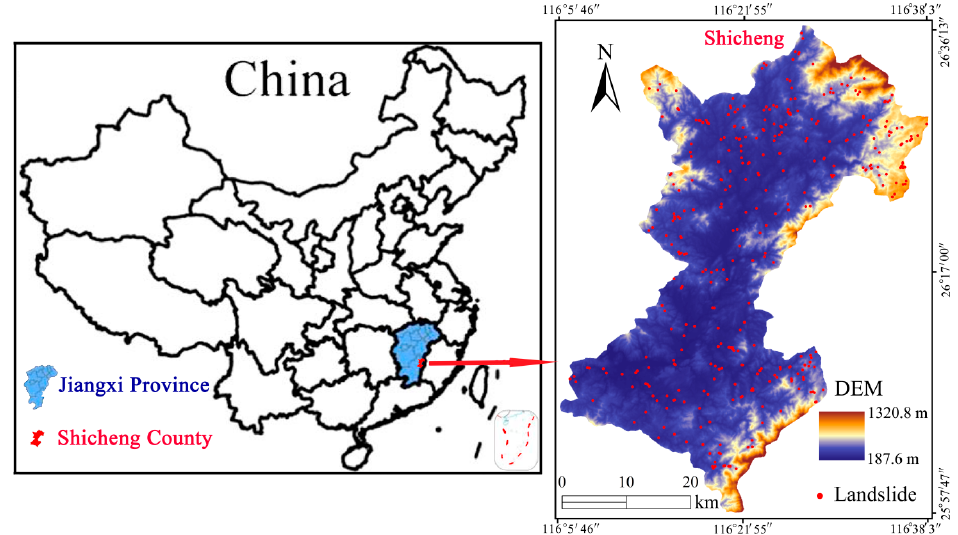
Figure 1. Location map in the study area. DEM: Digital elevation model.